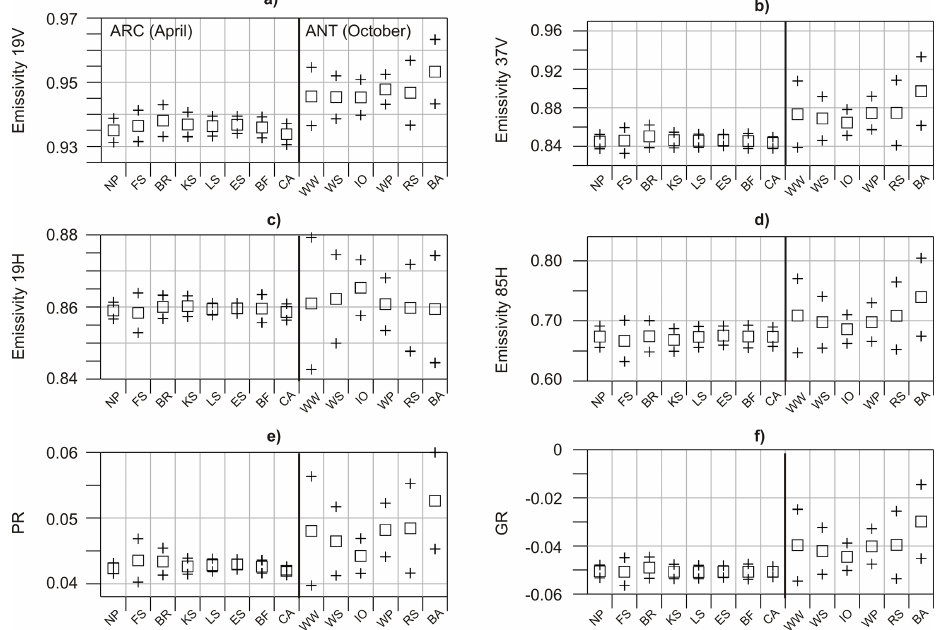
Fig. 5. Mean (squares) and standard deviation (crosses) of simulated emissivity values indicating the daily, spatial and inter-annual variability in the 4th month of simulation (ARC: April, ANT: October) for emissivities at (a) 19V, (b) 37V, (c) 19H, (d) 85H as well as (e) polarization ratio and (f) gradient ratio.